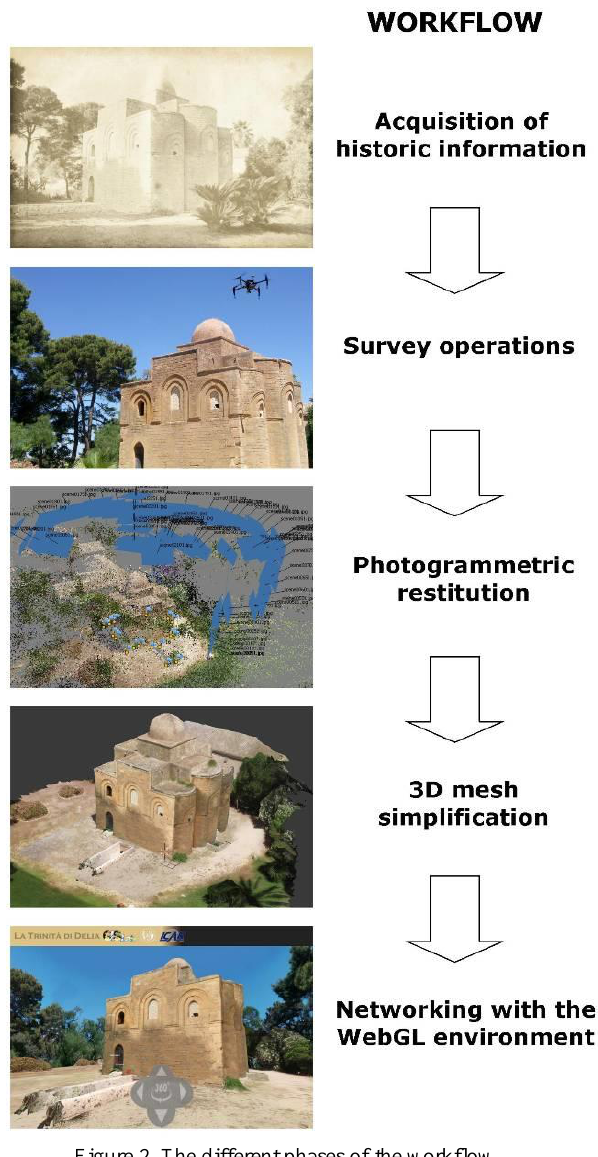
Figure 2. The different phases of the